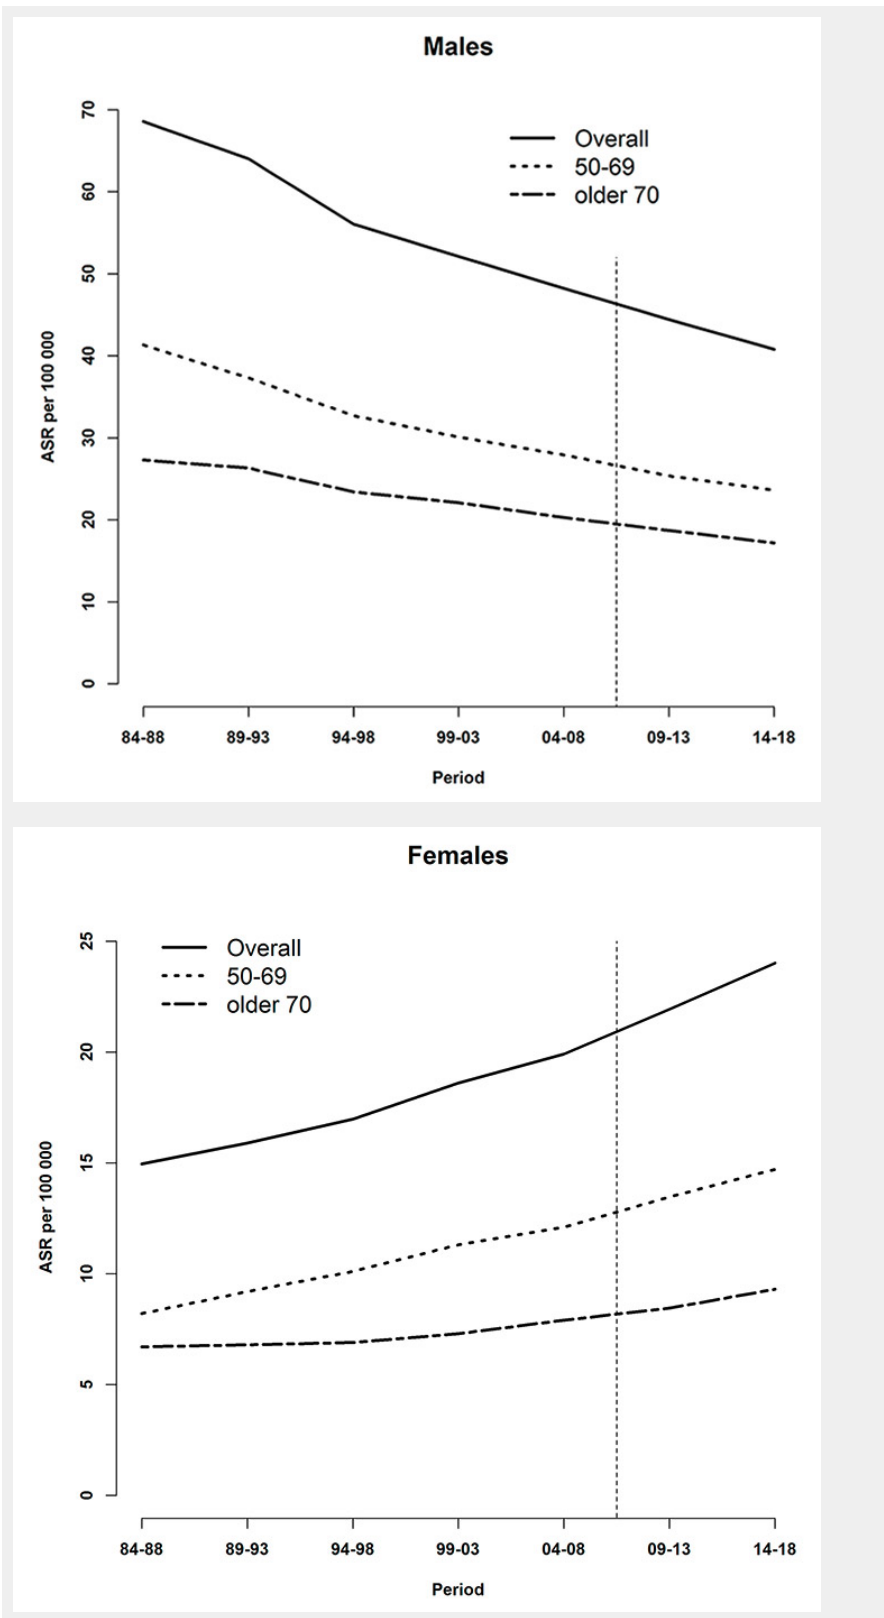
Figure 3 Age-specific and overall age-standardised tobacco-related cancer mortality rates (per 100,000), observed (during 1984–2008) and predicted (posterior median during 2009–2013 and 2014–2018) at the national level for (a) males and (b) females. The vertical line indicates the start of the prediction